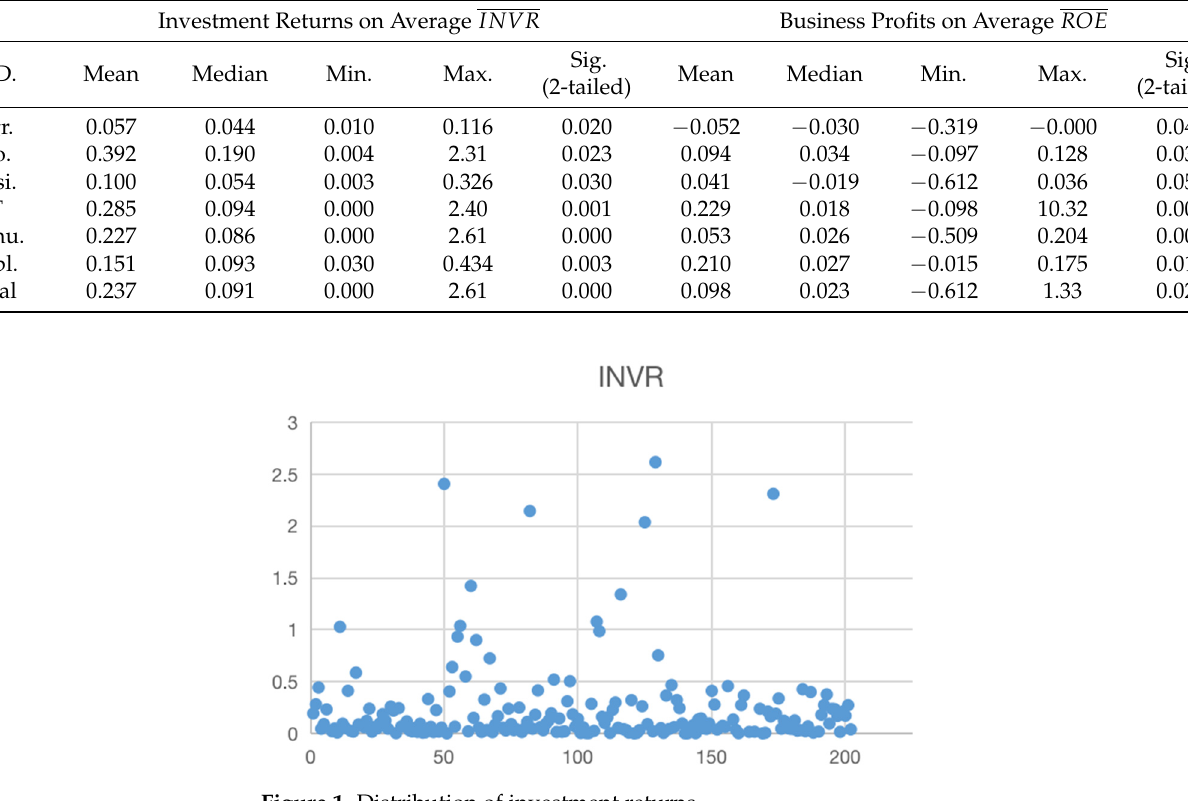
Figure 1. Distribution of investment returns.